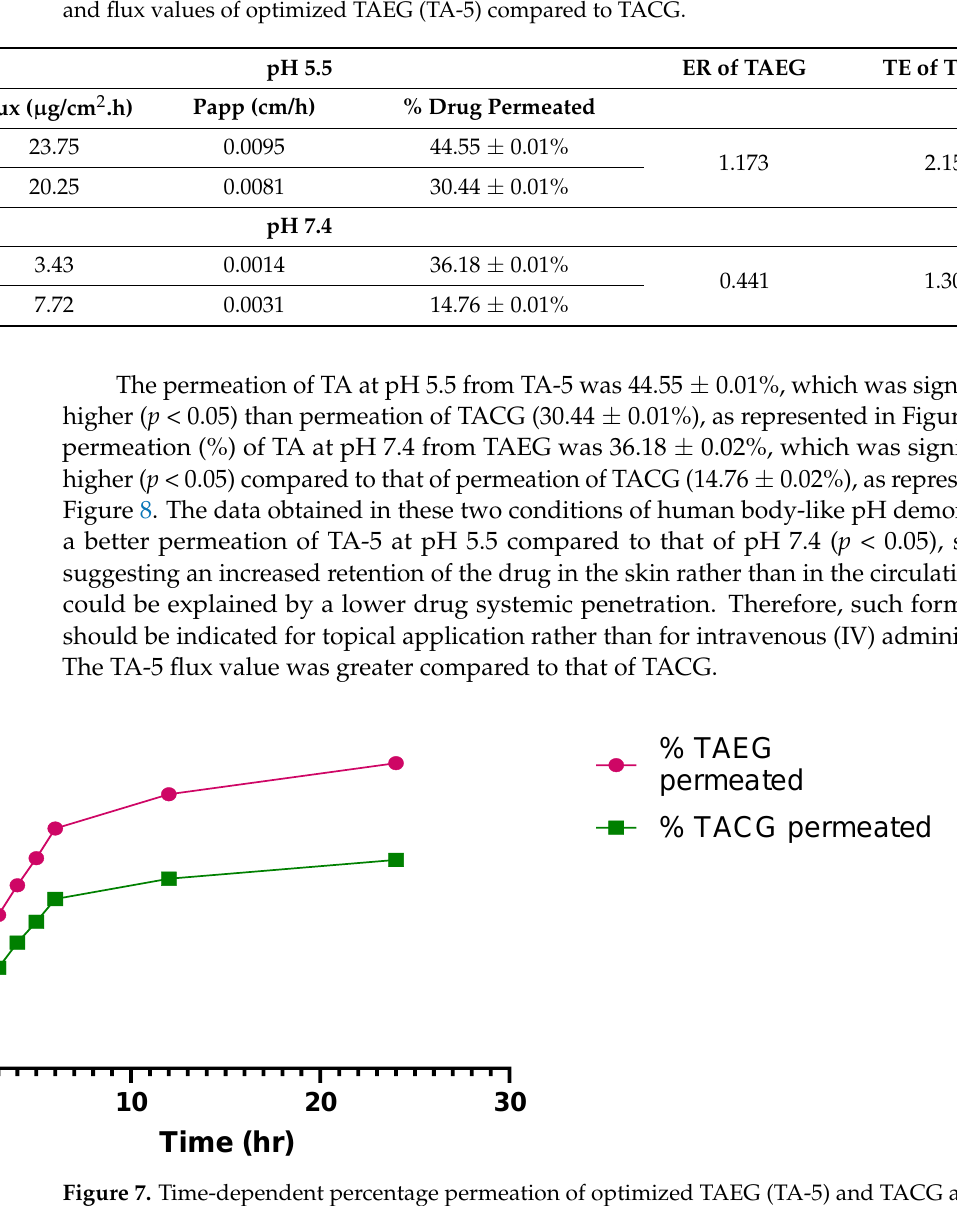
Table 4. Permeability coefficient, enhancement ratio (ER), targeting efficiency (TE), drug retention, and flux values of optimized TAEG (TA-5) compared to TACG.